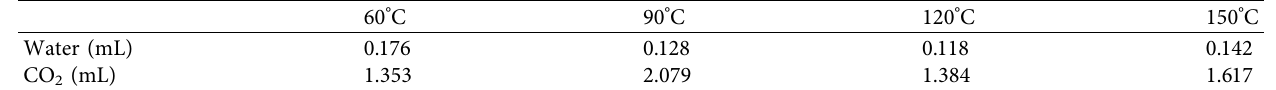
Table 5: The volume of injected fluid under different experimental